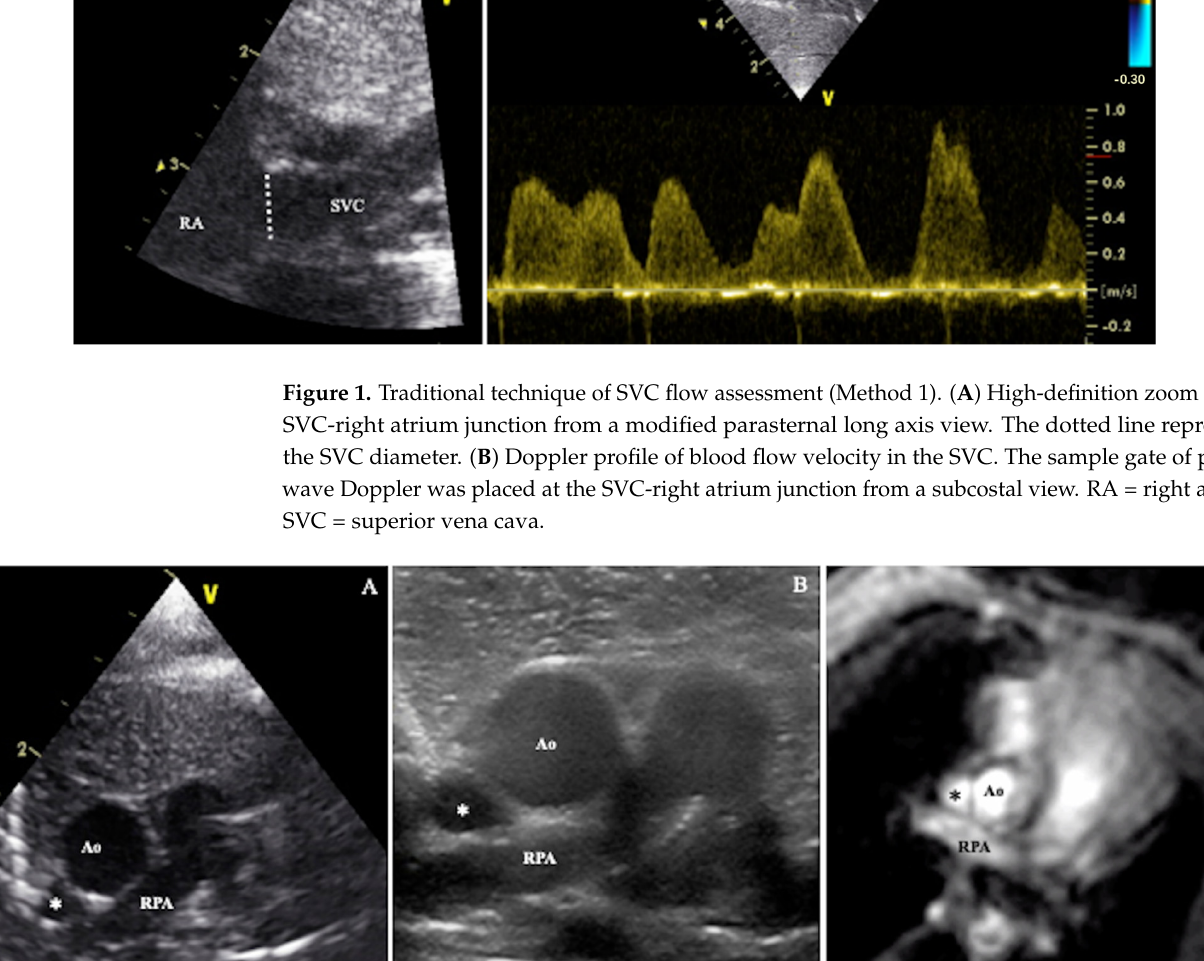
Figure 2. SVC cross-sectional area assessed by: ( A ) sector probe according to Method 2, ( B ) high frequency linear probe according to Method 3, ( C ) phase contrast magnetic resonance imaging . Ao = aorta, RPA = right pulmonary artery, * = superior vena cava .